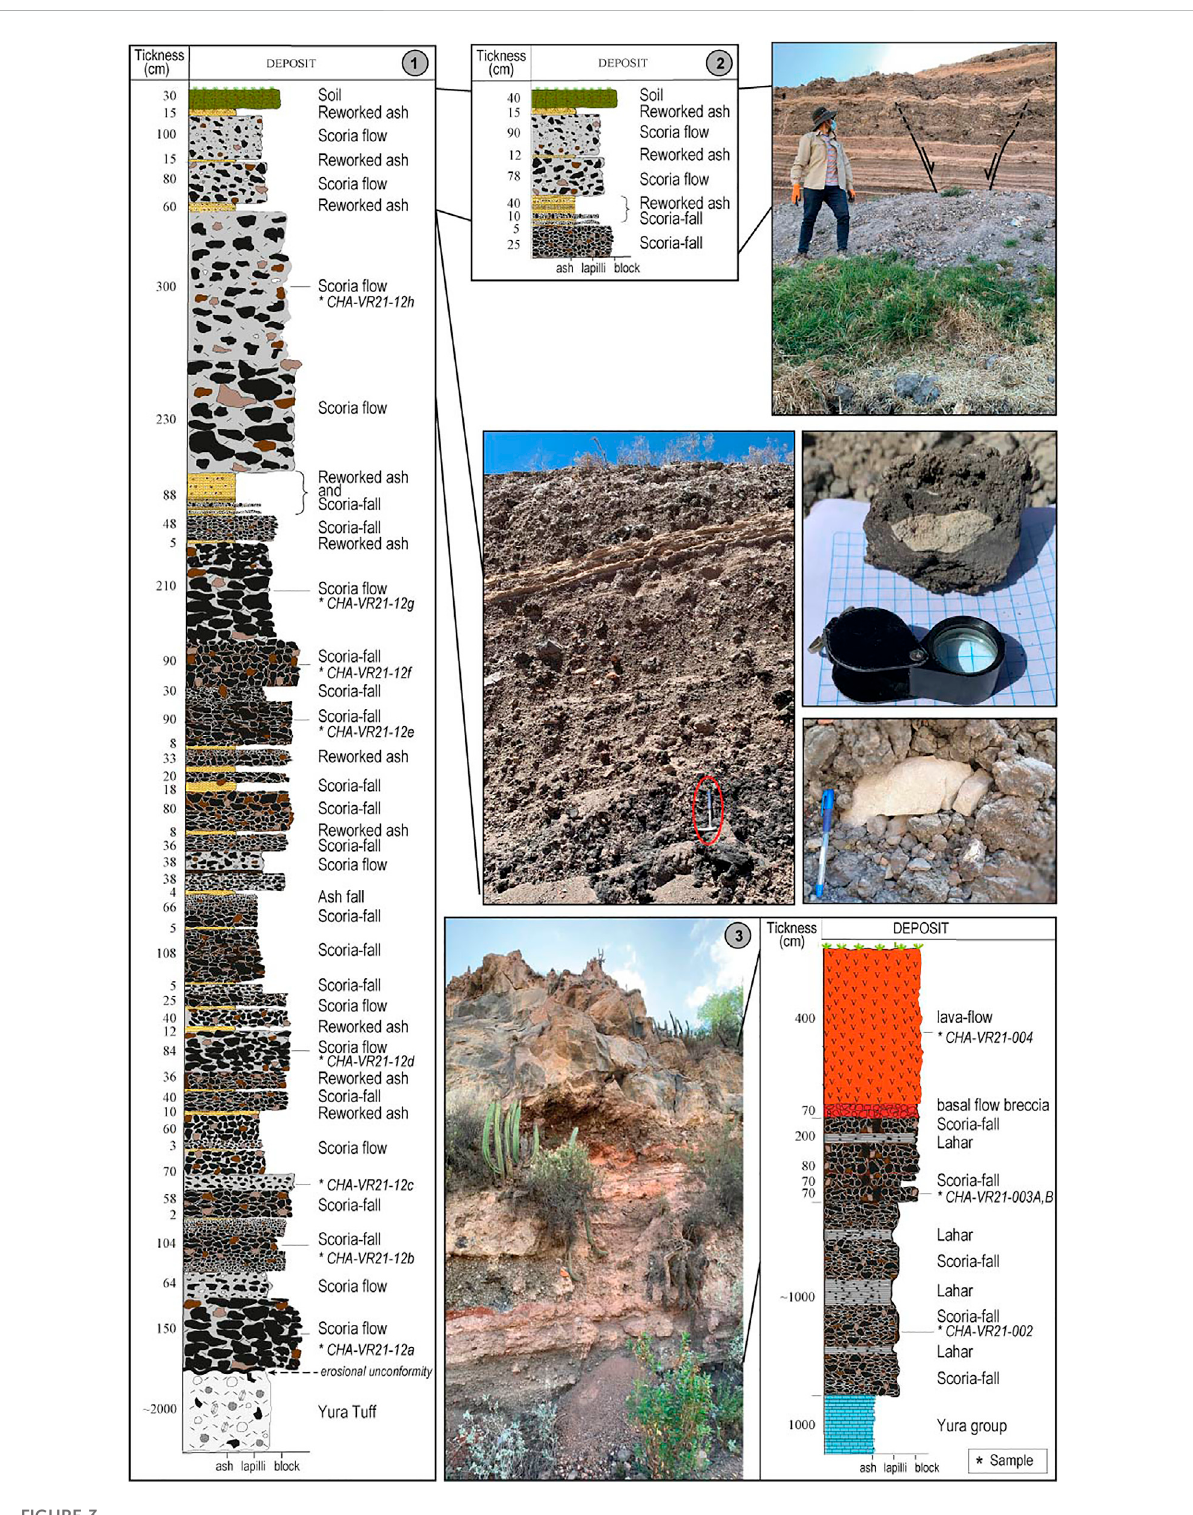
FIGURE 3 Stratigraphic sections described in outcrops of the Yura Viejo volcano. Photographs of outcrops of stratigraphic columns and the xenoliths included in the scoria blocks and fallout deposit. Black clasts in the deposits indicate the scoria, whereas the other colors indicate the lithics (sedimentary and rare ignimbrite lithics). The numbers (1, 2 and 3) indicate the location of the sections in Figure